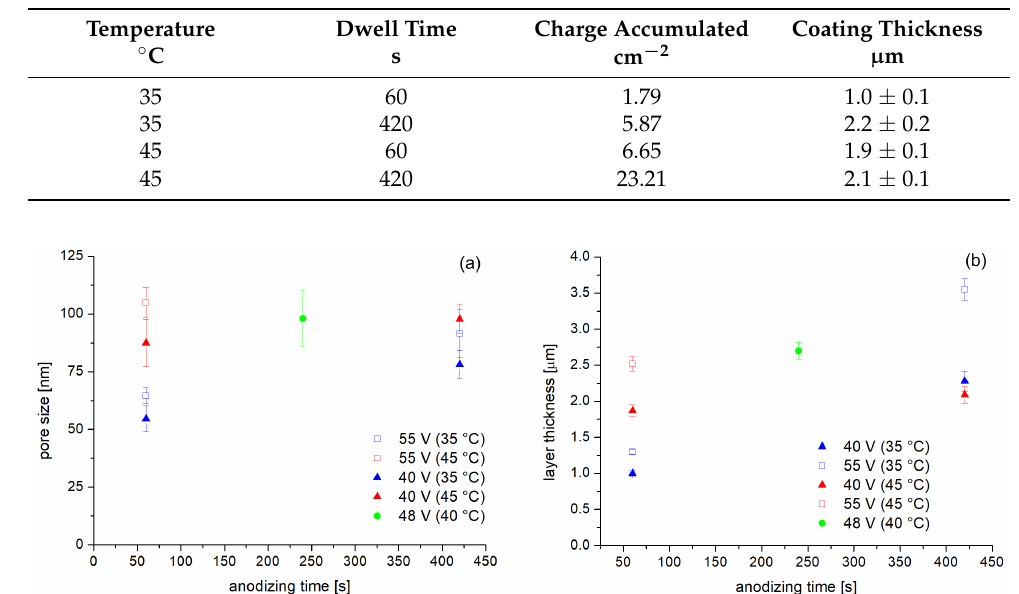
Table 2. Obtained coating thickness for different temperatures and dwell times at a constant voltage of V = 40 V.